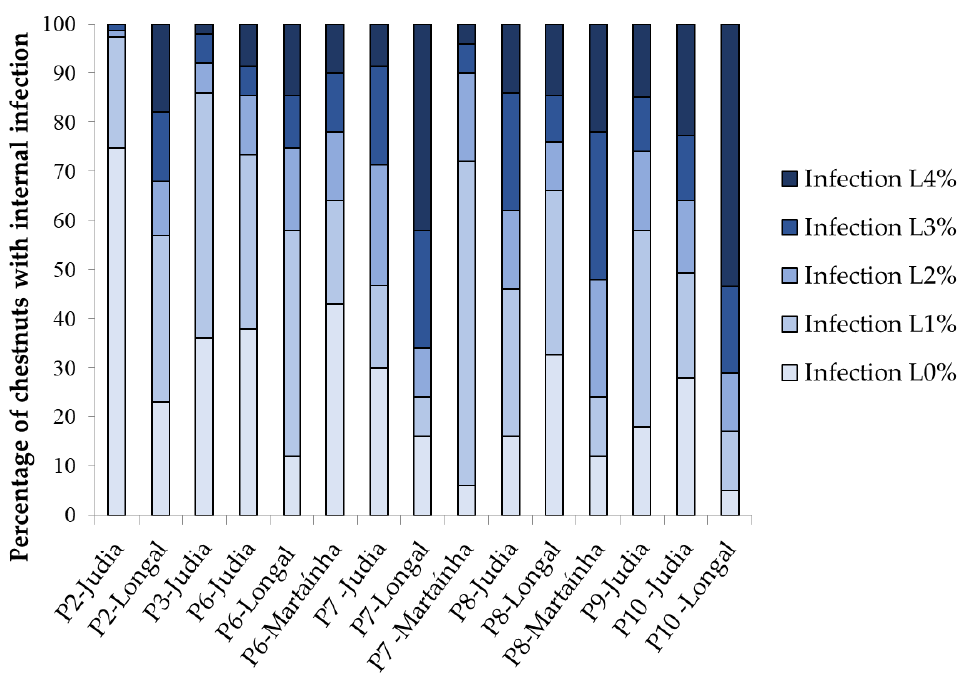
Figure 3. Percentage of chestnuts showing internal fungal infection at different processing stages for the varieties Longal, Judia and Martaínha. Levels of infection: L0 — no visible mold infection; L1—1–25% of chestnut internal surface covered by molds; L2—26–50%; L3—51–75%; L4: 76–100%.